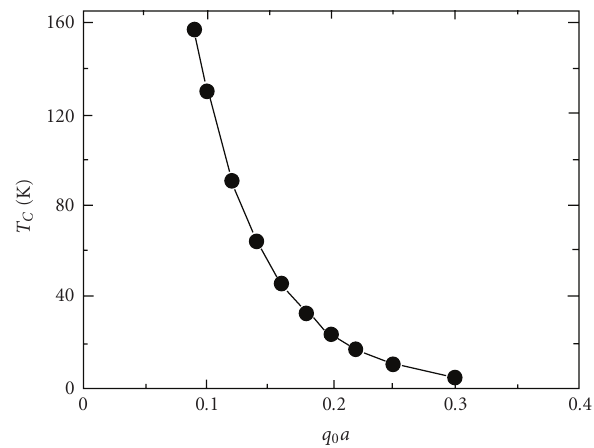
Figure 11: T C versus the screening parameter q 0 a , Details calcula- tions are done in [37].